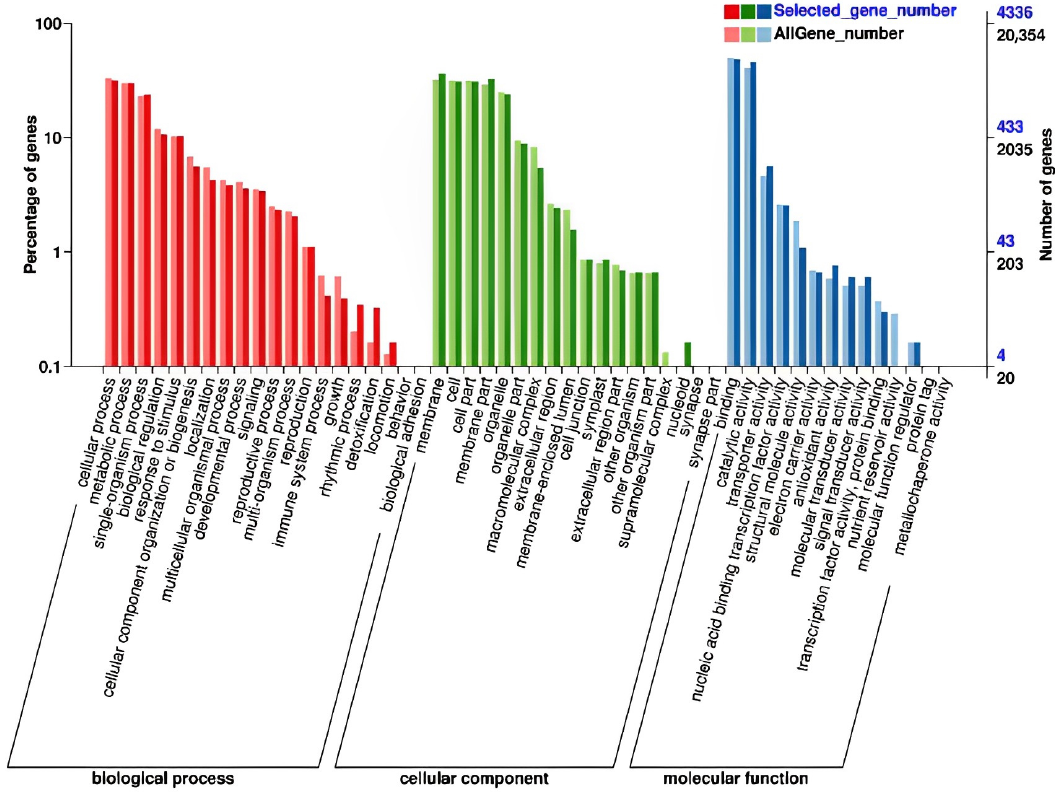
Figure 4. Summary of GO enrichment analysis. Biological processes, cellular components, and molecular functions are